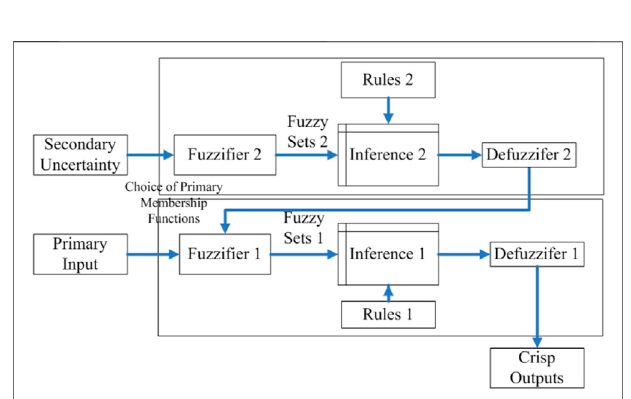
FIGURE 5 | Schematic diagram of the secondary-uncertainty – varying type 2 fuzzy logic